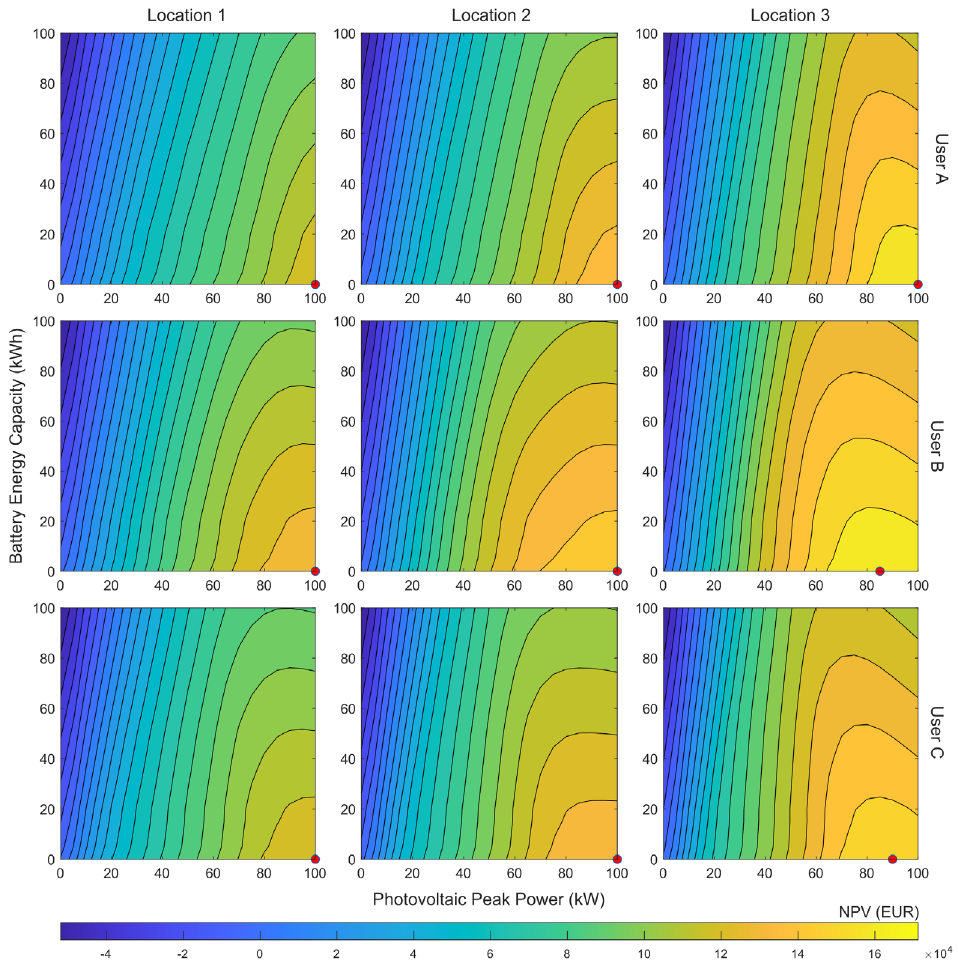
Figure 7. NPV for different combinations of battery capacity and PV power for the users and locations analyzed using self-consumption model 2 and 0% BESS price reduction. The red dots indicate the optimal solution for each scenario.